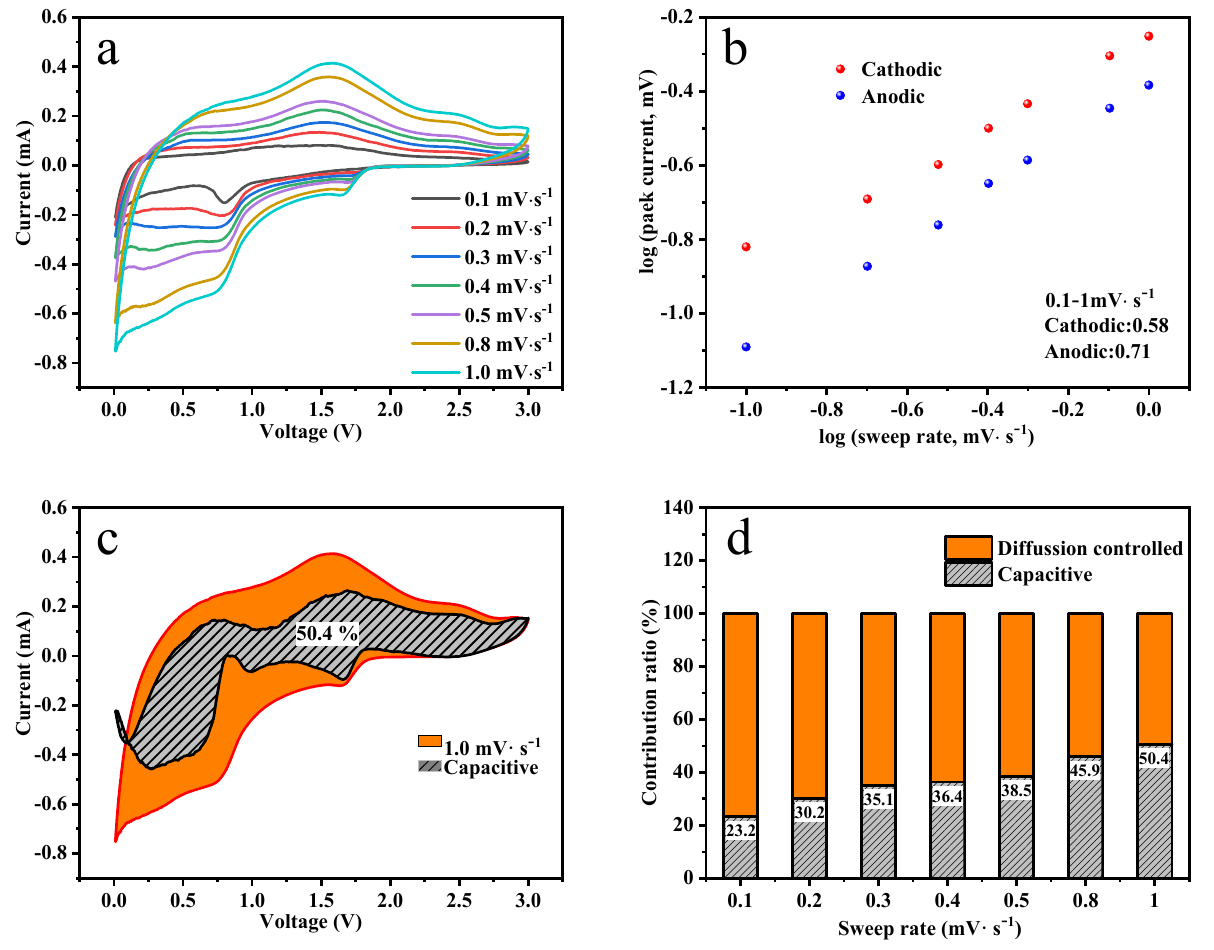
Figure 6. CV curves at different scanning rates from 0.1 to 1.0 mV s − 1 ( a ), the log (i)-log (v) plot ( b ); the calculated pseudocapacitive contribution diagram at the highest scanning voltage rate of 1.0 mV s − 1 ( c ) and full pseudocapacitive contribution ratios at different scanning rates ( d ) of the Fe 3 O 4 @C composite before cycling.